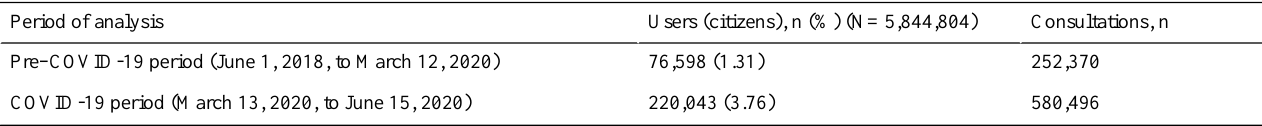
Table 2. eConsulta activity before and after the COVID-19